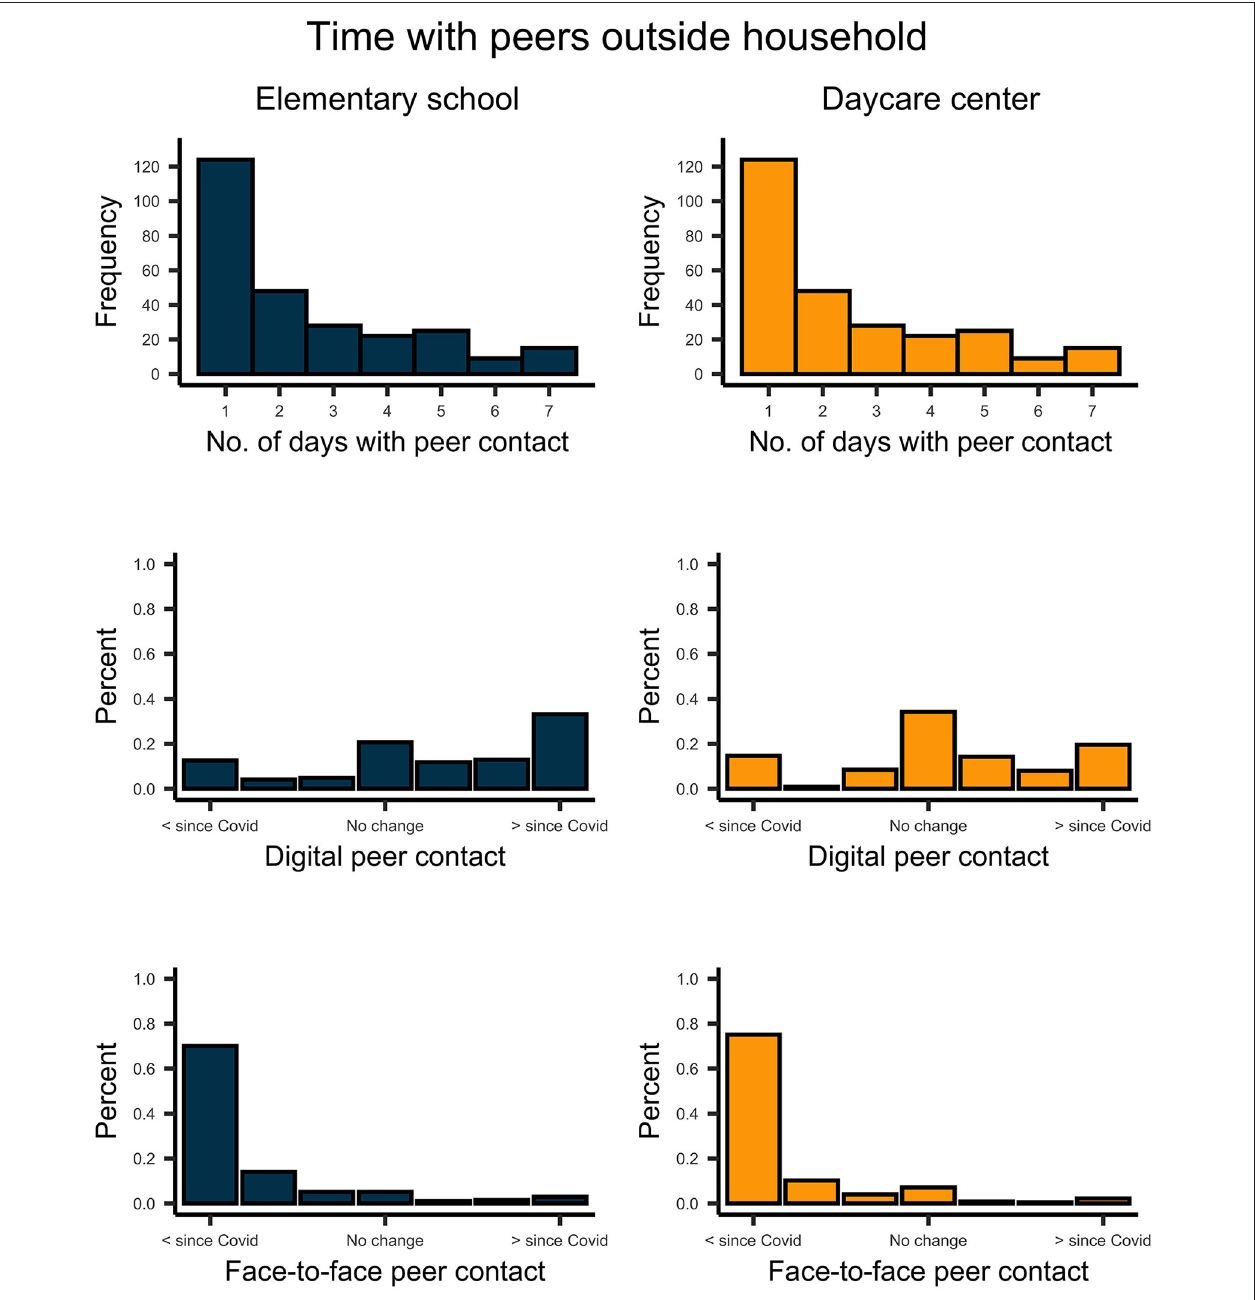
FIGURE 4 | Upper plots indicate the number of days per week on which school- and preschool-aged children had contact with peers living outside their household. Plots in the middle indicate the change of children’s digital peer contact since the COVID-19 pandemic. Lower plots indicate the change of children’s face-to-face peer contact since the COVID-19